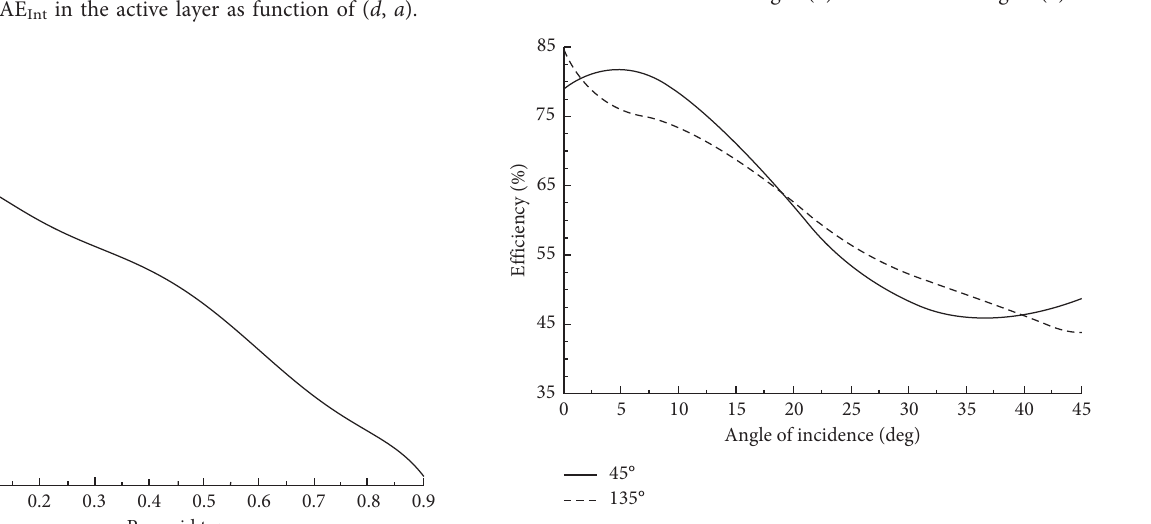
Figure 17: Integrated absorption efficiency (AE the angle of incidence ( θ ) for TM incidence and with equal Azi- muth angles 45 ° and 135 °